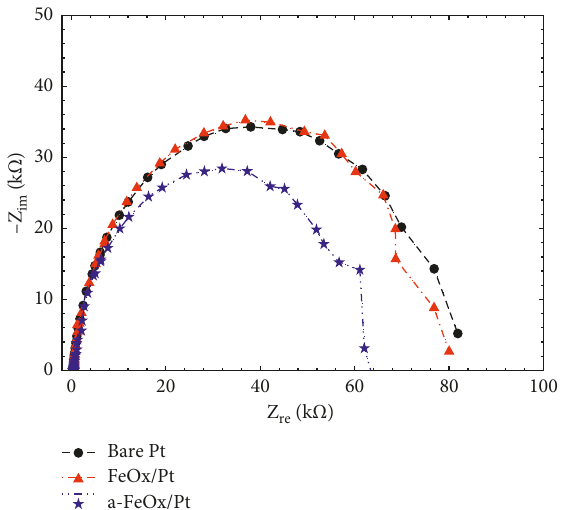
Figure 7: Nyquist plots at open circuit potentials for bare Pt (a), FeOx/Pt (b), and a-FeOx/Pt ( − 0.5 V) (c) electrodes in 0.3M FA (pH �